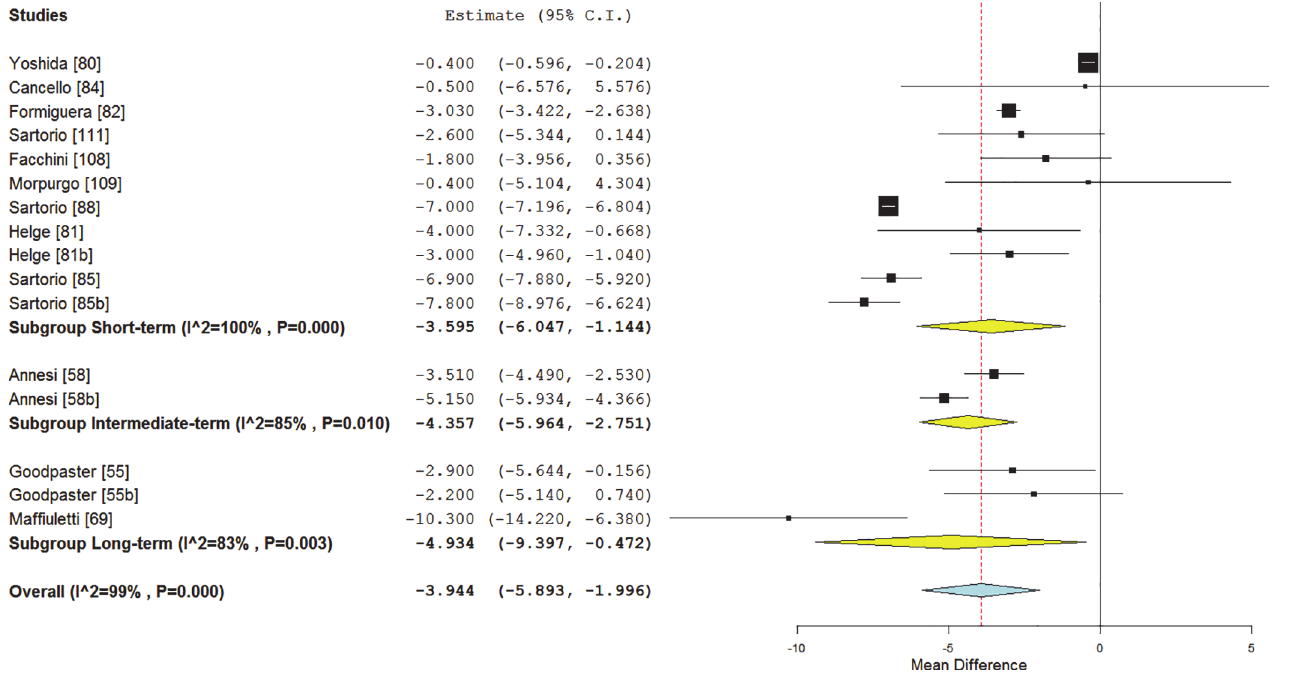
Fig 3. Forest plot of mean fat mass changes according to the intervention length in class II and III obese individuals.